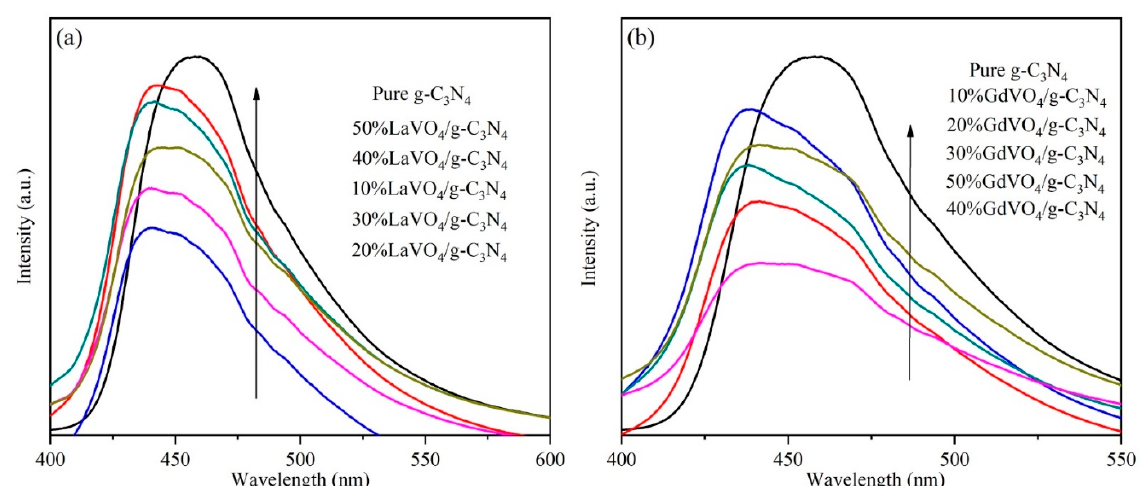
Figure 6. The photoluminescence of ( a ) g-C 3 N 4 and 10–50%LaVO 4 /g-C 3 N 4 , ( b ) g-C 3 N 4 and 10–50%GdVO 4 /g-C 3 N 4.